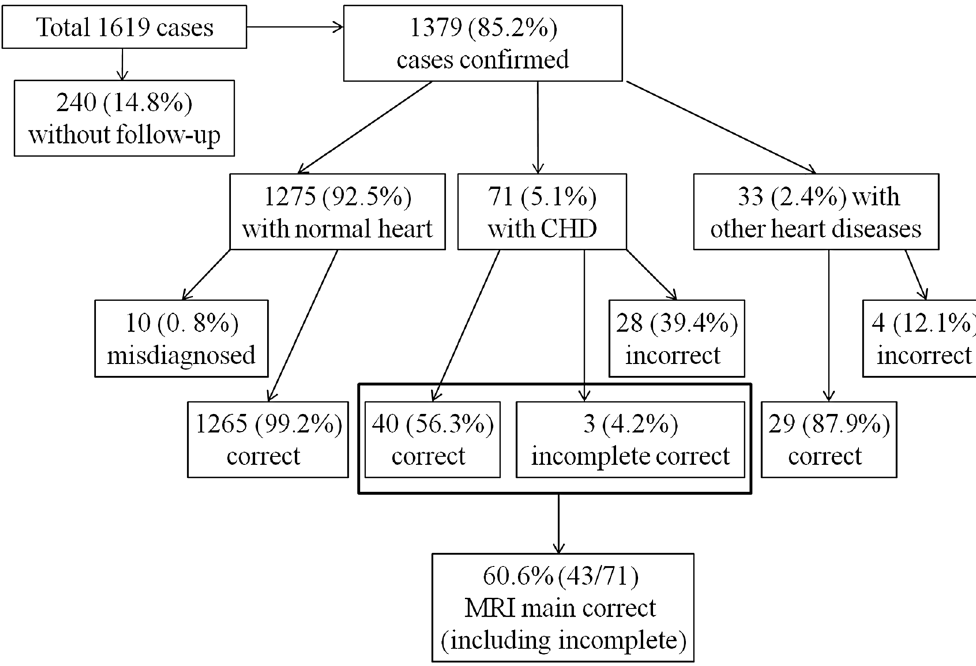
Figure 3. Diagram demonstrating all cases in this study. Diagram demonstrating all cases interpreted by foetal cardiac MRI and confirmed by postnatal diagnoses.